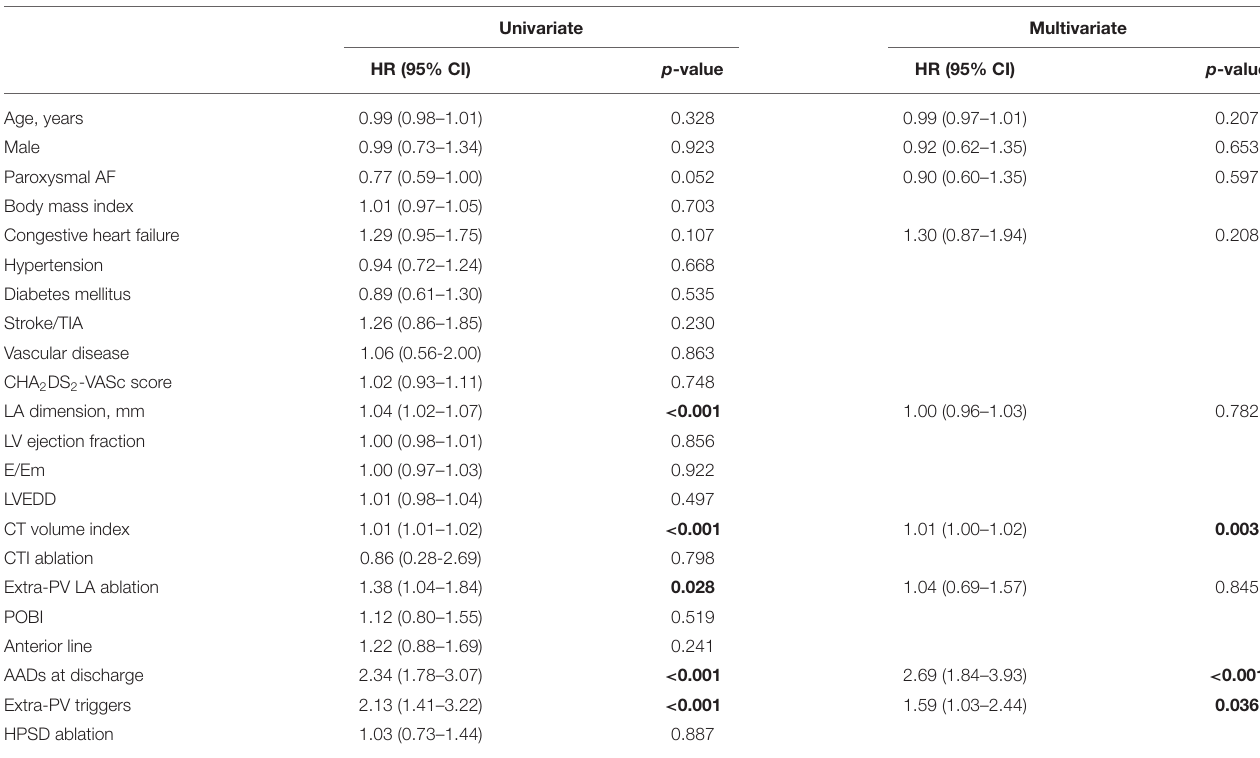
TABLE 4 | Cox regression analysis for 1-year clinical recurrence.